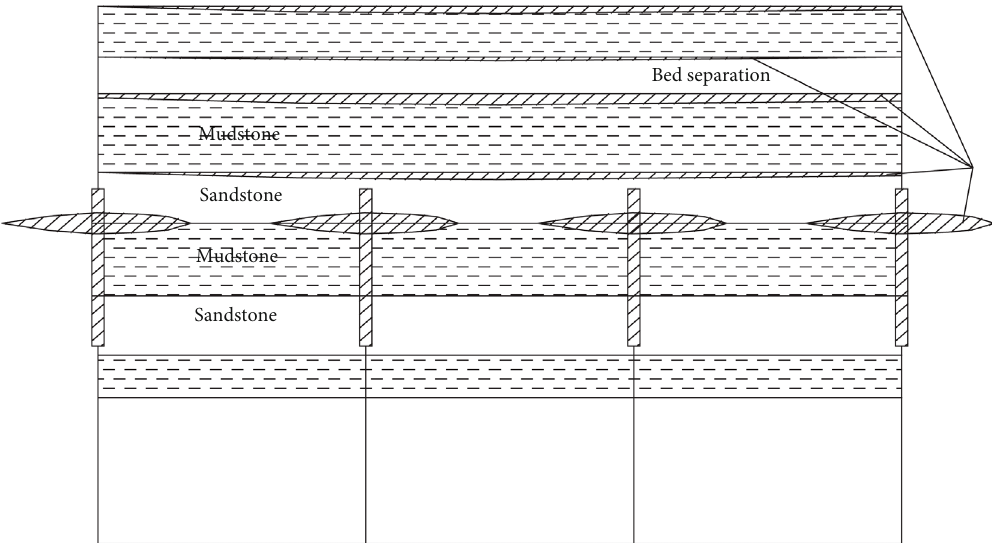
Figure 4: The diagram of composite roof separation.